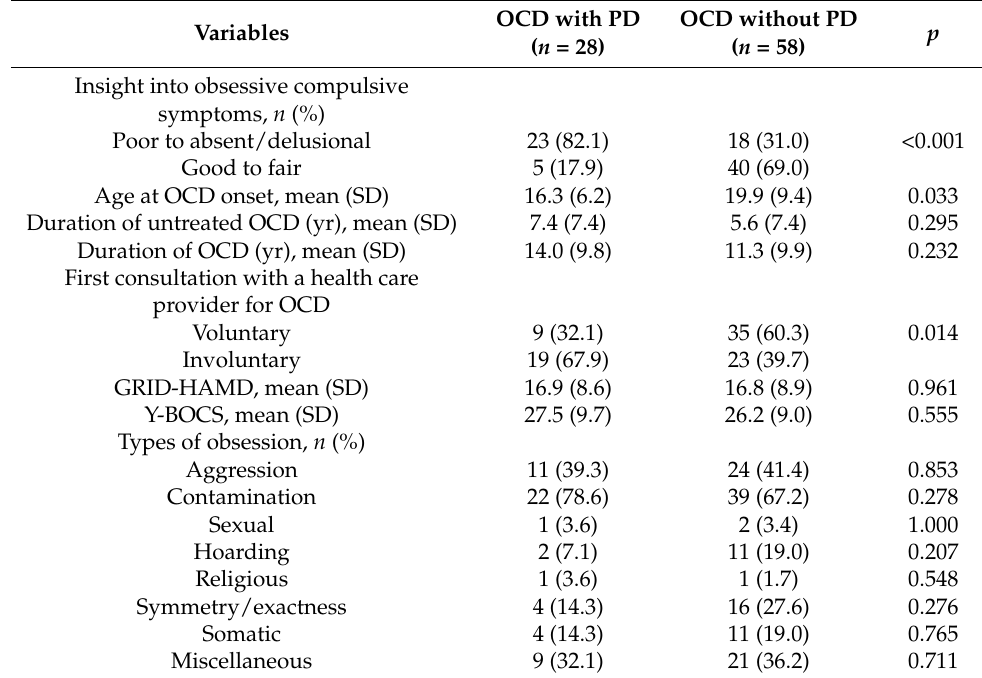
Table 2. Comparison between OCD with psychotic disorder ( n = 28) and OCD without psychotic disorder ( n = 58): clinical features and